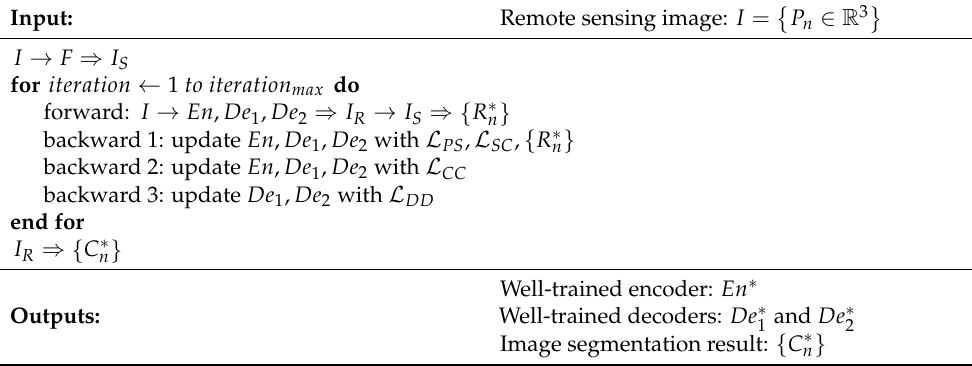
Table 1. Overview of the training process for our multi-model framework.